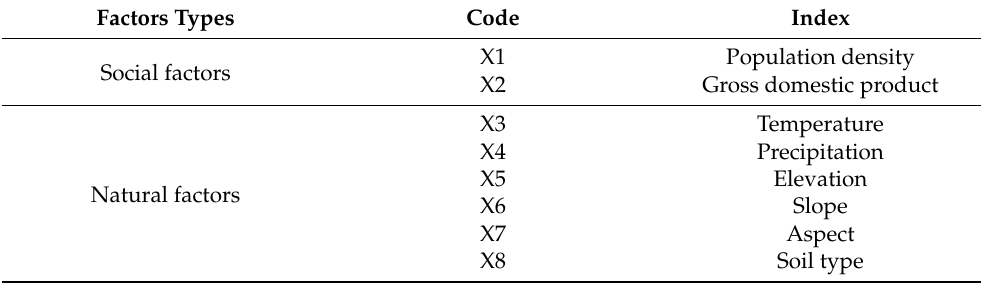
Table 1. Factors influencing the LULC changes.